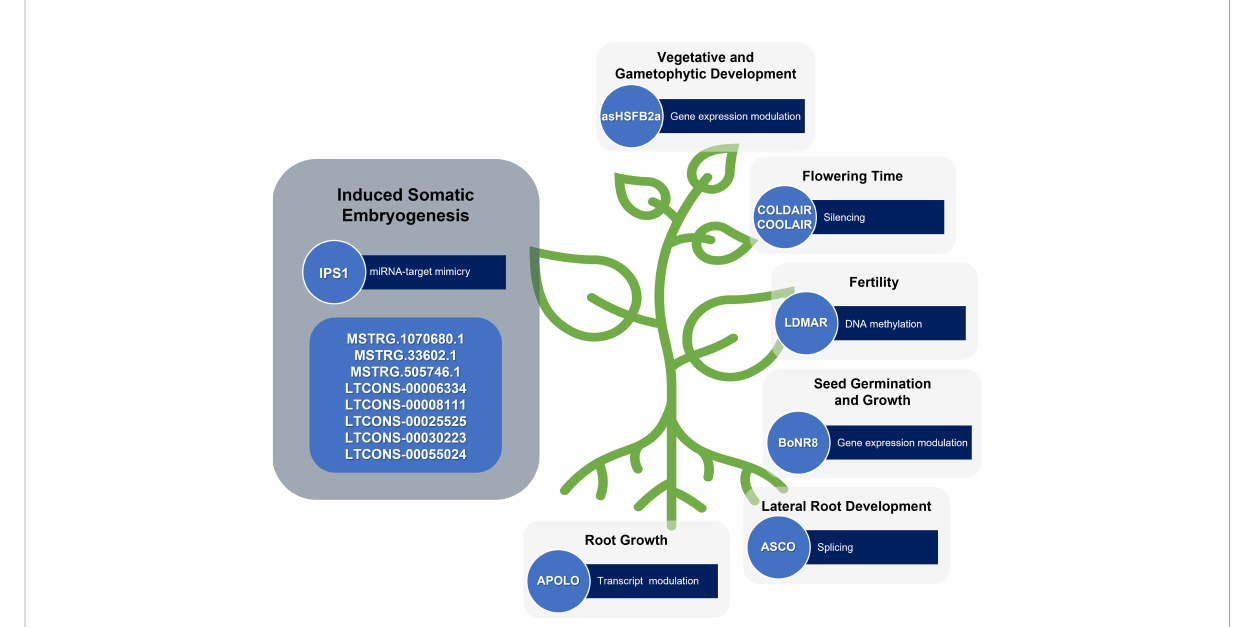
FIGURE 3 lncRNAs involved in induced plant somatic embryogenesis and other developmental processes. Some lncRNAs still require functional